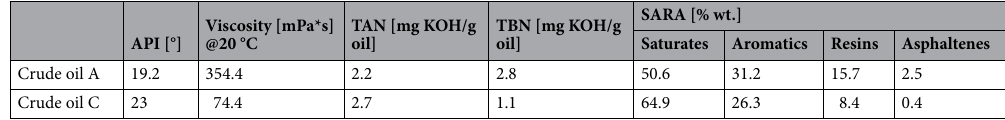
Table 3. Crude oils properties. Viscosity data for 20 °C. Both oils were used in previous reports of our group and the naming convention is kept for consistency 36 . TAN and TBN are the total acid and base numbers, respectively.